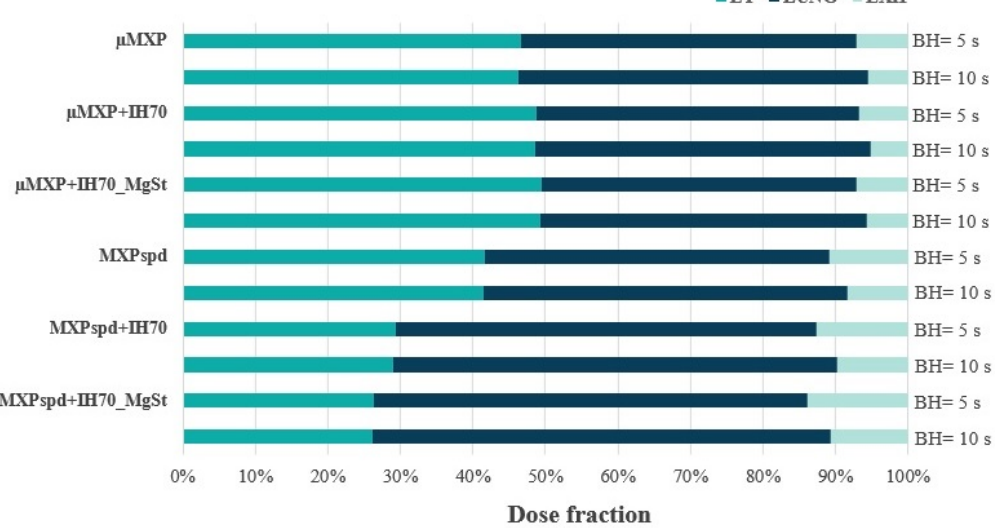
Figure 4. In silico simulation results of the studied DPI formulations (ET: extrathoracic airways; LUNG: bronchial and acinar parts; EXH: exhalation fraction).